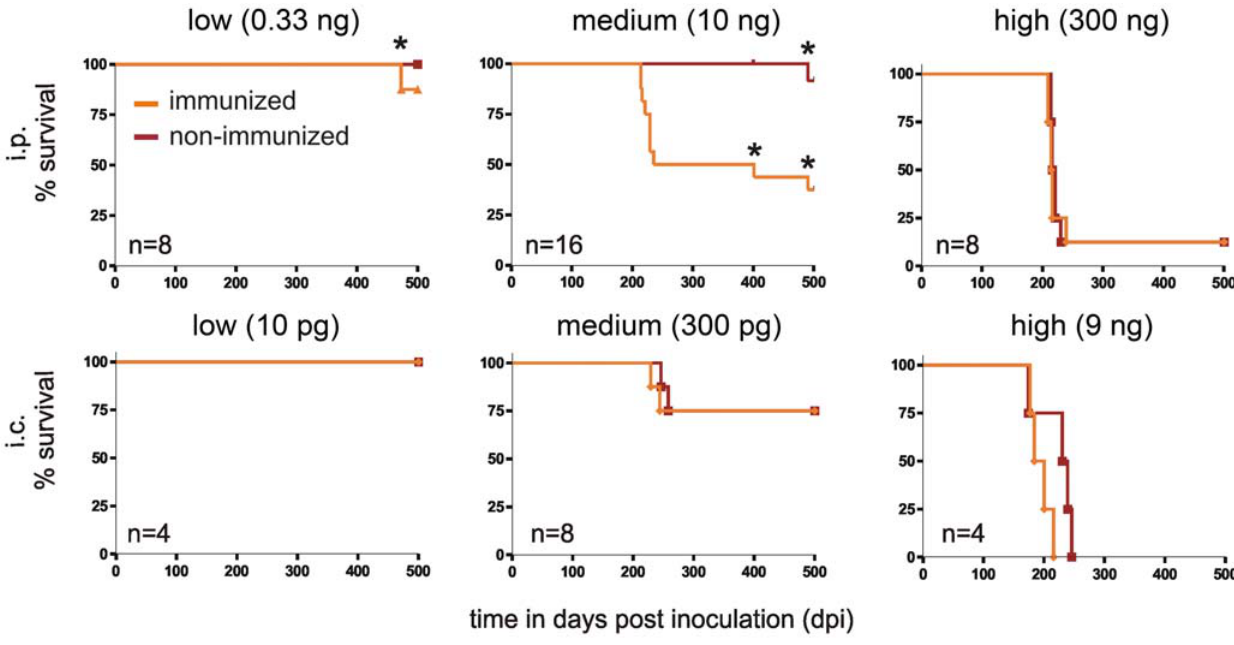
Figure 4. Survival of immunized (i) and non-immunized (ni) mice inoculated intraperitoneally (i.p.) or intracerebrally (i.c.) with prions. While all mice inoculated i.p. or i.c. with a low dose of prions (0.33 ng i.p. or 10 pg i.c. RML6 brain homogenate; left panel) survived until 500 dpi, all mice inoculated i.c. with a high dose of prions (9 ng; right lower panel) died of scrapie. Seven of 8 mice (87.5%) inoculated i.p. with a high dose of prions (300 ng) succumbed to scrapie independently of immunization (right upper panel). In the medium dose group (10 ng i.p. or 300 pg i.c.; medium panels) there was no difference in survival rates in i.c. inoculated mice (75% in both groups). While non-immunized mice inoculated i.p. with a medium dose of prions remained healthy, 50% of the immunized mice developed scrapie. Intercurrent deaths (not scrapie-associated) occurred . 400 dpi; time points are marked with a star above the curve. All brains of mice dying without clinical signs of scrapie were tested by Western blot and did not contain PrP Sc (data not